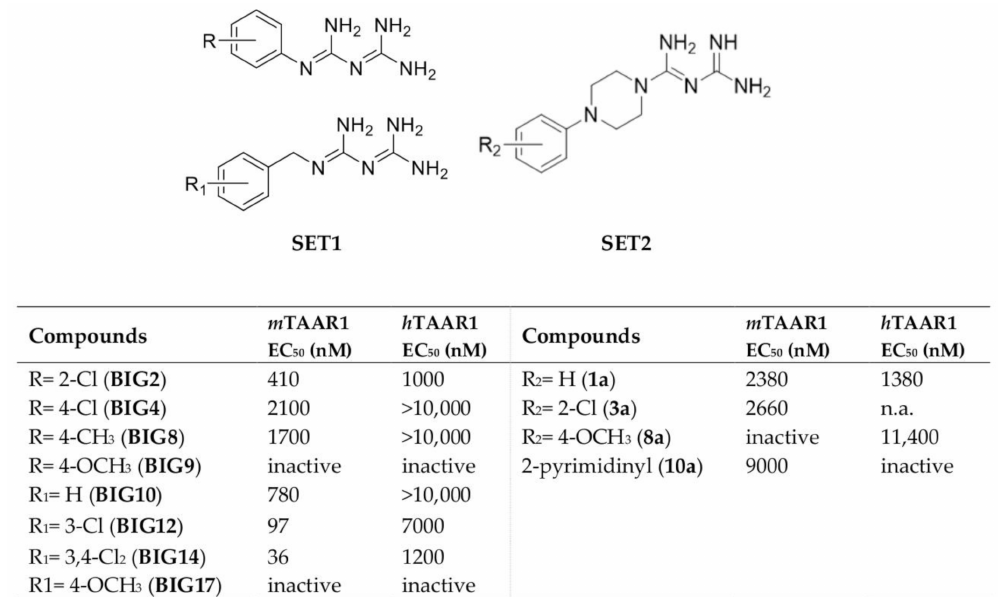
Figure 2. Chemical structure of previously studied biguanide-based derivatives as m / h TAAR1 agonists